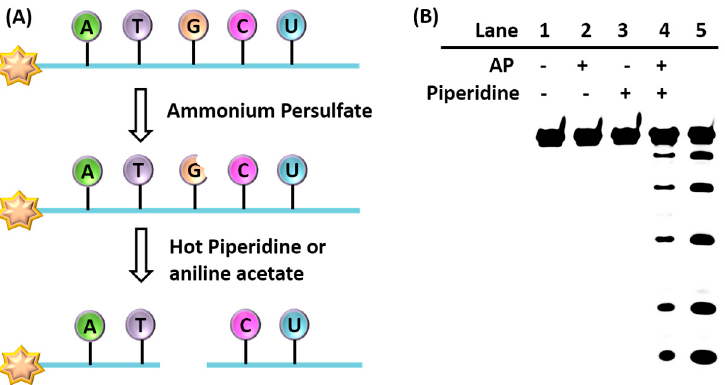
Figure 1. ( A ) Schematic illustration of nucleic acid sequences oxidized by AP and then cleaved by hot piperidine or aniline acetate; ( B ) Polyacrylamide gel electrophoresis experiments showing cleavage products of HEX-labeled DNA of ODN-mismatch (20 pmol) incubated with AP in Tris-HCl buffer (pH = 7.4). Lane 1: DNA alone; lane 2: ODN with AP; lane 3: ODN with piperidine; lane 4: ODN with AP and piperidine; lane 5: G-ladder of ODN (treated with DMS).